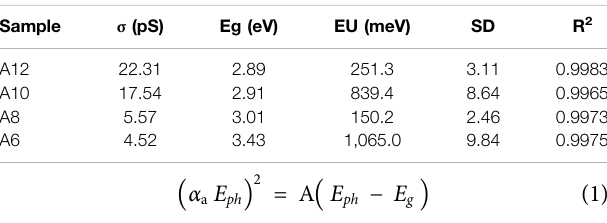
TABLE 2 | Values of the electric conductance, σ , energy gap, Eg, and Urbach energy, E U , of An series.